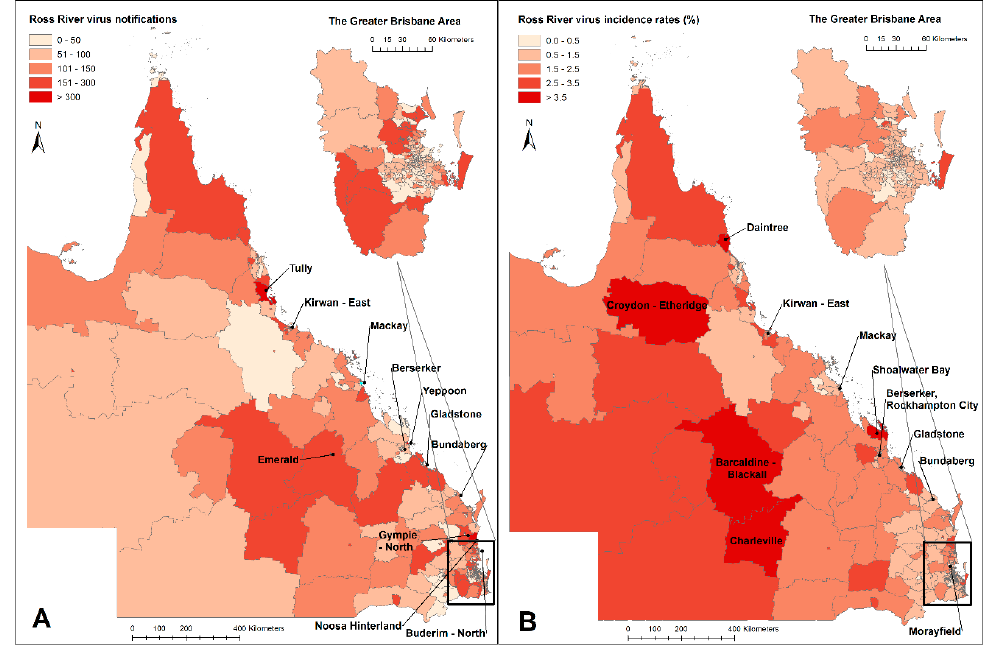
Figure 3. Spatial distribution of Ross River virus total notifications ( A ) and cumulative incidence ( B ) in Queensland, 2001–2020. SA2 areas with over 300 notifications and cumulative incidence over 350 cases per a population 10,000 are named in the figure.